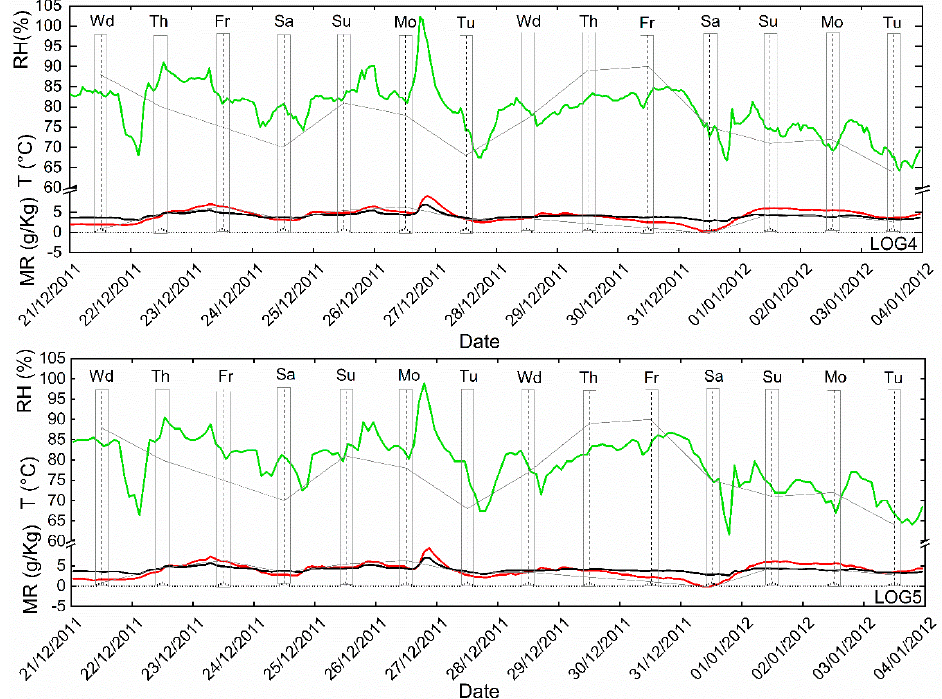
Figure 12. Indoor RH (%)-green line, T (°C)-red line, mixing ration (MR) (g/Kg)-black line values for Christmas week representative of microclimate conditions and churchgoers’ presence in winter as measured by Log4 (top plot) and Log5 (bottom plot). The grey line refers to outdoor RH values collected by the Kristiansund lufthavn weather station. Daylight duration is highlighted by rectangular areas.